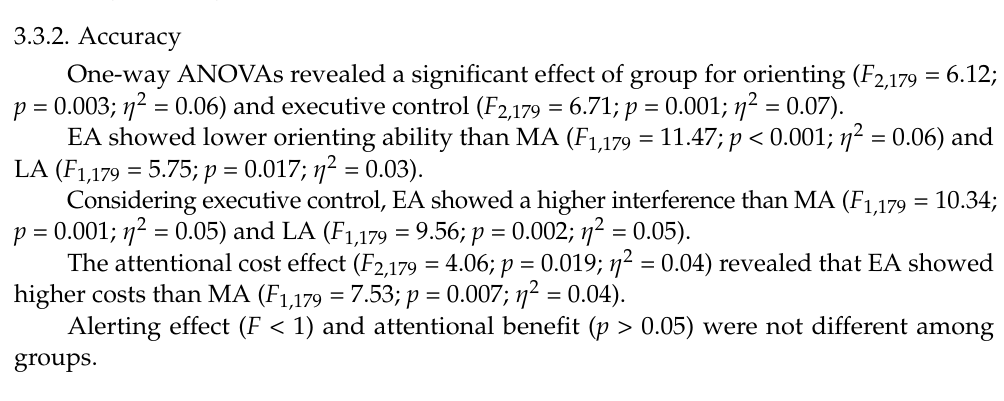
Figure 3. Mean reaction times of attentional effects: alerting, orienting, executive control, costs, and benefits. * p = 0.01; ** p < 0.01. benefits. * p = 0.01; ** p <